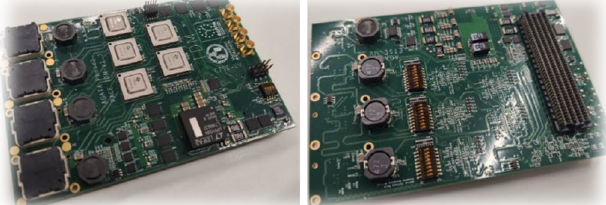
Fig. 1. The IDM mezzanine with the aggregation concept. It is the original demonstrator for AGATA Phase 2 and a modular solution for other instrumentation